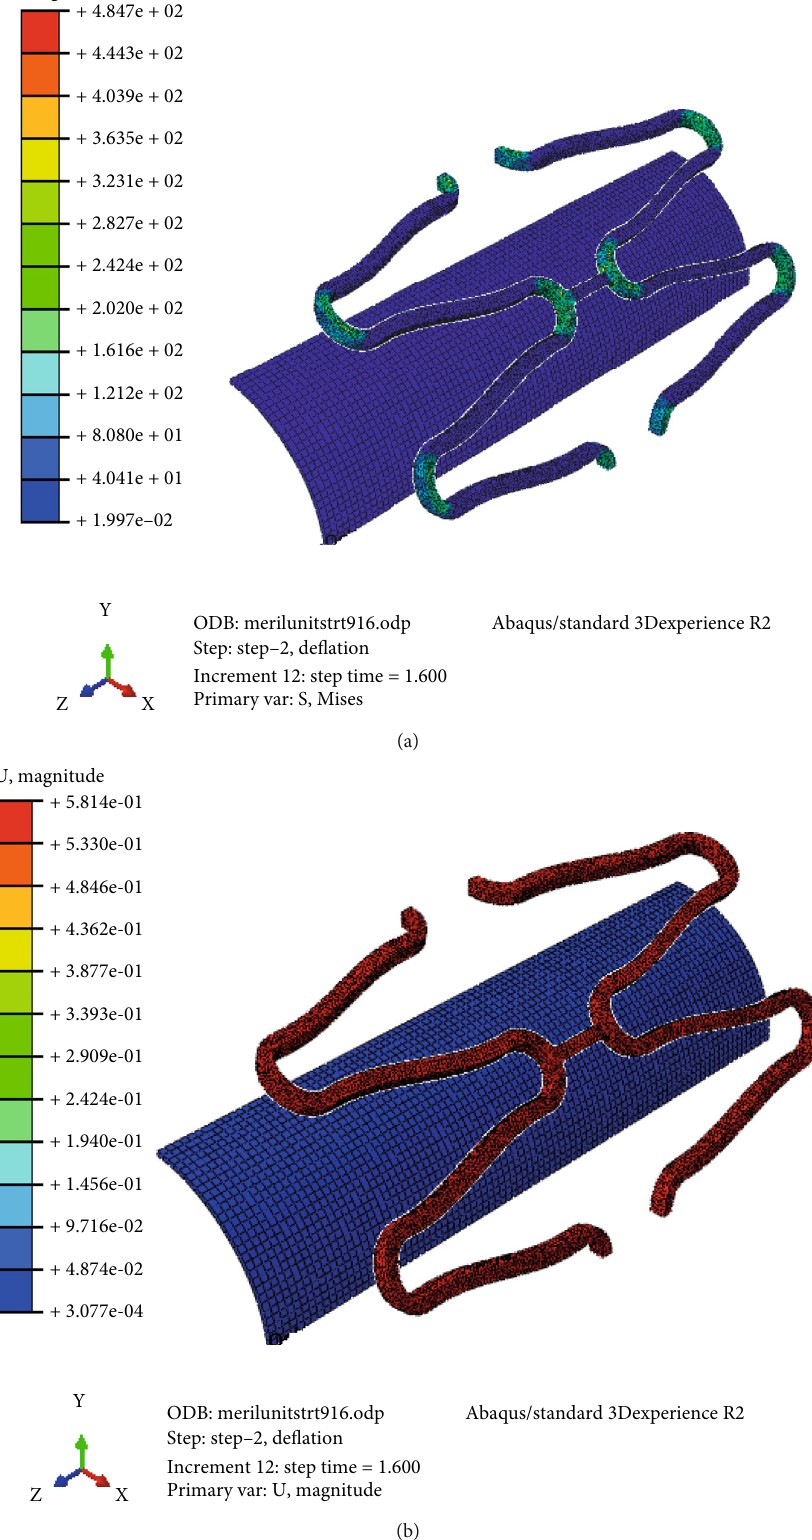
Figure 16: (a) Stress distribution on stent with straight connector. (b) Strain distribution on stent with straight